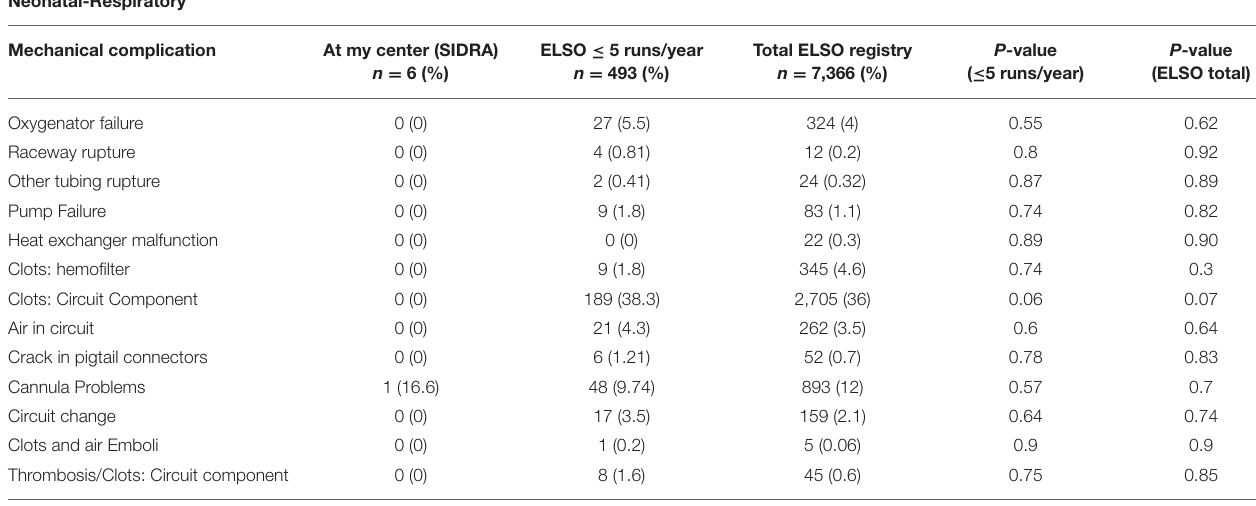
TABLE 3 | Benchmarking of mechanical complications in SIDRA ECMO program against other ELSO centers registry data of neonatal and pediatric group.